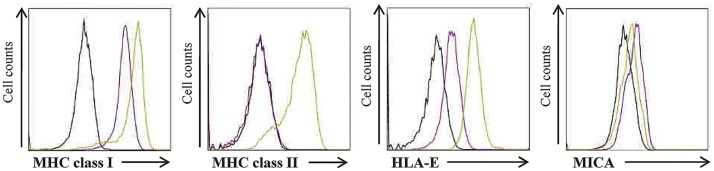
Basal versus IFNγ-modulated expression of MHC class I, MHC class II, HLA-E and MICA on EC cultures.ECs were treated with or without IFNγ for 48h before analysis. Data shown are representative histograms from Facs analysis showing constitutive versus IFNγ-regulated expression of inflammatory molecules (MHC class I, MHC class II, HLA-E and MICA) at the EC surface. Histograms show the intensity of fluorescence (log, x-axis) versus cell number (y-axis) for untreated (purple line) and cytokine-treated (green line) ECs analyzed by flow cytometry. Immunostaining using an irrelevant isotype-matched IgG (dark line) was used as a negative control.